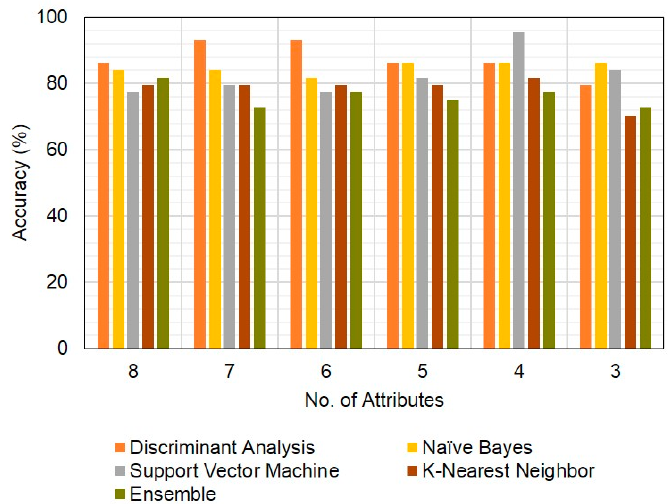
Figure 19. Accuracy for testing wells by machine learning methods and number or attributes.